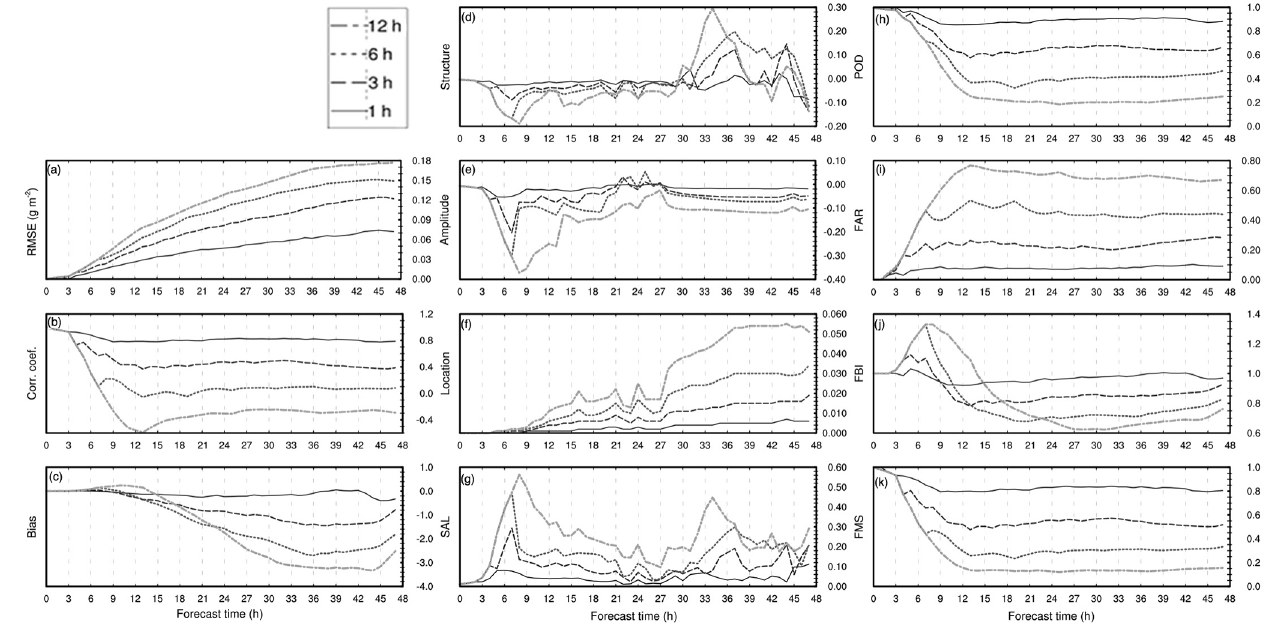
Figure 9. Online vs. offline evaluation scores for the 2010 Eyjafjallajökull